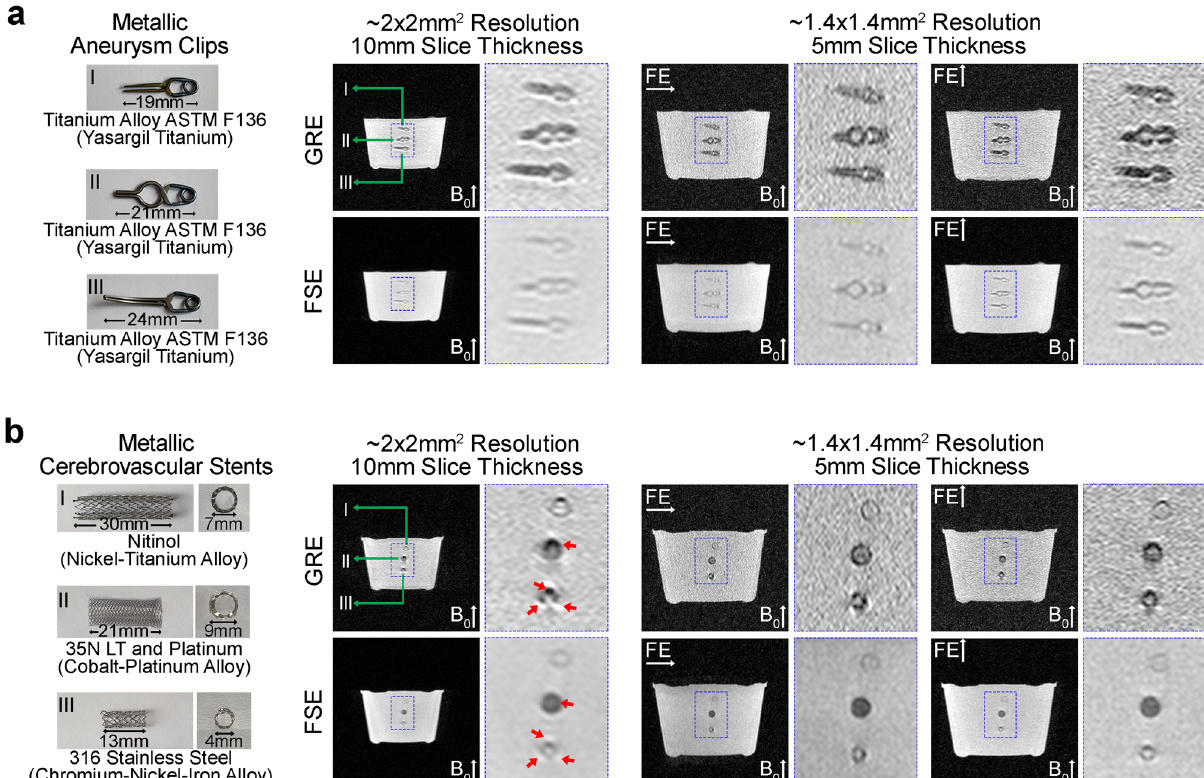
Fig. 8 Low sensitivity to commonly used clinical metal implants at 0.055 T. Illustration of metal implants (left) and corresponding images acquired at 0.055 T (right) of a titanium alloy aneurysm clips and, b cerebrovascular stents with three distinct types of metal alloys. Metal-induced image artifacts were dramatically reduced at 0.055 T. Almost no visible artifacts were present around the titanium alloy metal clips and the nickel-titanium alloy stent. Slight artifacts were visible in the images for the cobalt-platinum alloy and stainless-steel stents (indicated by red arrows). These implants were immersed in water and imaged with the 3D axial GRE and FSE sequences with FE direction along horizontal or vertical direction. Note that the main fi eld 0.055 T was along the vertical